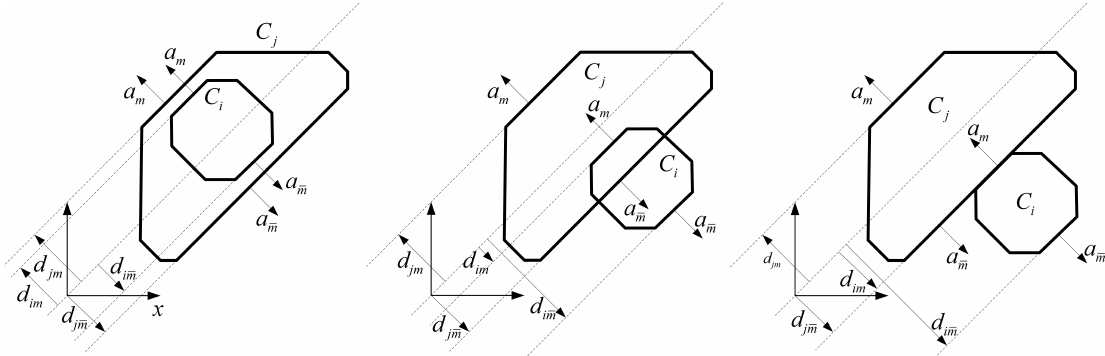
Figure 4. Topological relation descriptor (TRED). The CTI descriptor elements d xm that are denoted with arrows directed opposite the corresponding vector a m have negative